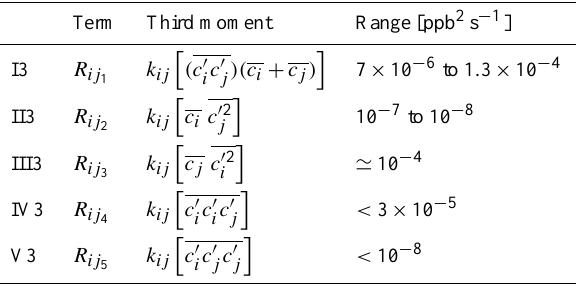
Table 4. Order of magnitude (amount) of the five third-order terms (I3)–(V3) (as indicated by number 3) of R ij [ppb 2 s − 1 ] (Eq. 10) according to the analysis in Sect. 5.3 (see also Fig.